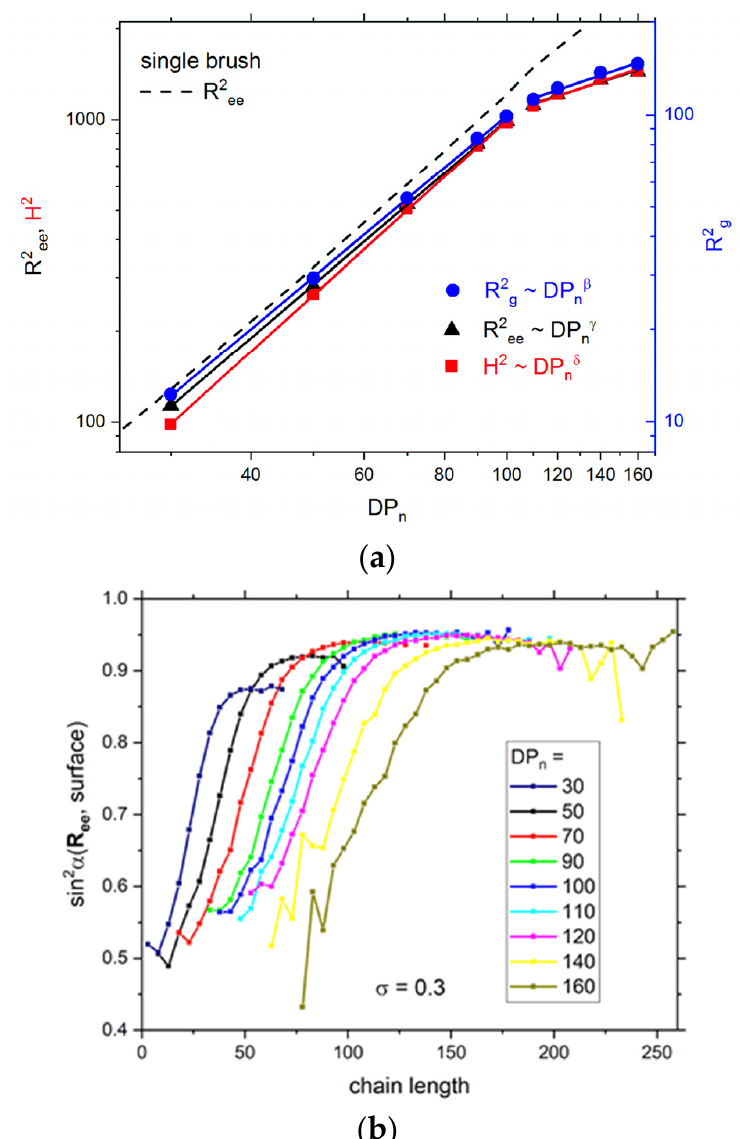
Figure 2. Mean squared end-to-end distance R 2 ee , mean squared height H 2 , and mean squared radius of gyration R 2 g as a function of DP n ; the results for a single polymer brush are presented as a dashed line for comparison (based on simulations presented in [22]) ( a ). The angle between an end-to-end vector and the grafting surface (chains’ tilt angles) as a function of the chain length for different DP n values ( b ). The case of σ = 0.3.